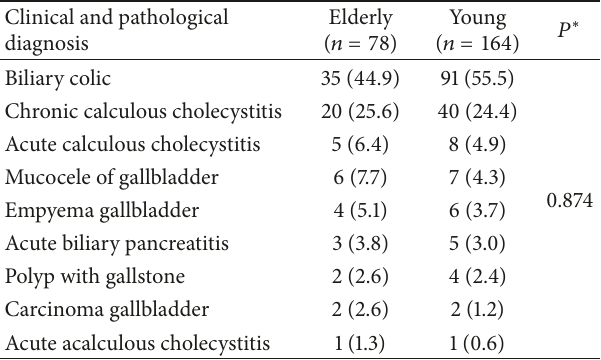
Table 2: Indications for laparoscopic